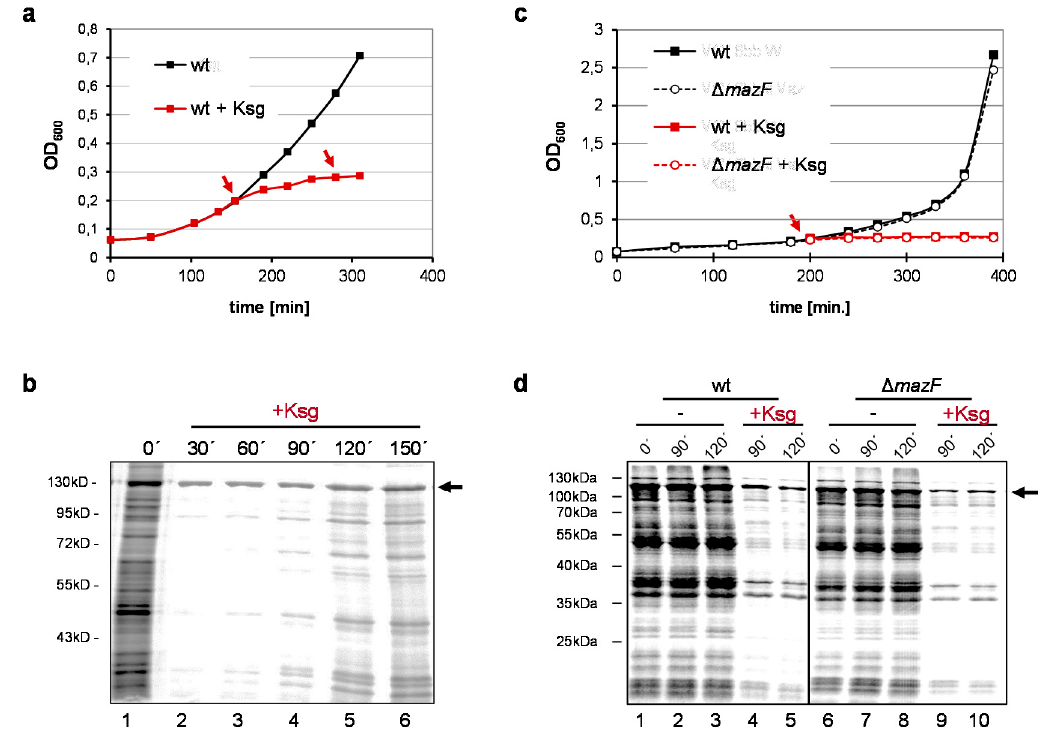
Figure 1. Prolonged Ksg treatment triggers selective protein synthesis. ( a ) Growth of strain MG1655 harboring plasmid pRB381-1, encoding the leaderless cI-lacZ fusion gene in the absence (black) and presence of 0.5 mg/ml Ksg (red line) was monitored by measuring the optical density at 600 nm. Addition of Ksg is indicated by red arrows. Error bars representing the standard deviation of triplicate samples are hidden by the symbols. ( b ) At indicated time points before and after addition of Ksg pulse labeling was performed and the labelled proteins were separated by SDS-PAGE. The position of the CI-LacZ fusion protein is indicated by an arrow. ( c ) Growth of strain MG1655 (solid line) in the absence (black) and presence of 0.5 mg/ml Ksg (red line) was compared to growth of strain MG1655 ∆ mazF (dotted line) both harboring plasmid pRB381-1. Addition of Ksg is indicated by a red arrow. Again, error bars representing the standard deviation of triplicate samples are hidden by the symbols. ( d ) At time points indicated pulse labeling was performed and the labelled proteins were separated by SDS-PAGE. The arrow indicates the CI-LacZ fusion protein.